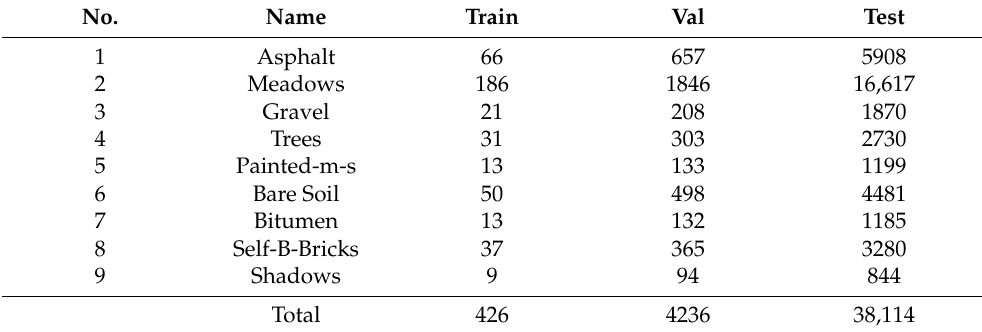
Table 1. The number of training, validation and testing samples for University of Pavia dataset.